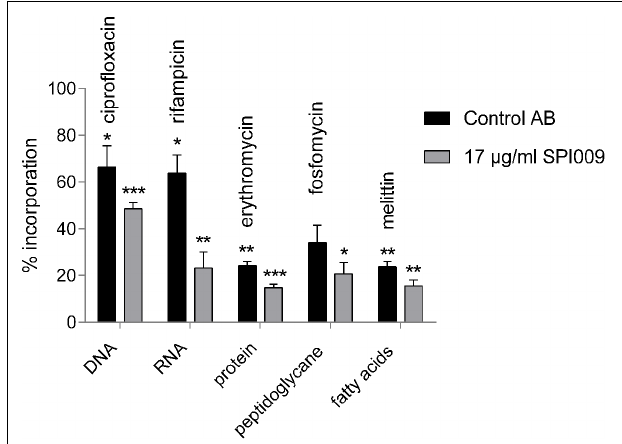
FIGURE 3 | SPI009 inhibits macromolecular synthesis. Incorporation of [methyl- 3 H]-thymidine (DNA), [5,6- 3 H]-uridine (RNA), L -(4,5- 3 H)-leucine (protein), D -[6- 3 H(N)]-glucosamine (peptidoglycan), 2- 3 H-glycerol (fatty acids) by P. aeruginosa PA14 WT after treatment with relevant control antibiotics at 8 × MIC concentrations or 17 µ g/mL of SPI009. Incorporation was measured after 30 min and expressed relative to an untreated control. Bars represent the average of at least three independent repeats ± SEM. Statistical analysis was performed on “counts per minute” obtained upon radioactivity detection after treatment of the bacterial cells with MQ (untreated control), the control antibiotic or 17 µ g/mL SPI009. One-way ANOVA ( α = 0.05) with appropriate correction for multiple testing was used to determine statistically relevant differences between the untreated control and antibiotic or untreated control and SPI009 treatment. ∗ P < 0.05; ∗∗ P < 0.01; ∗∗∗ P < 0.001.